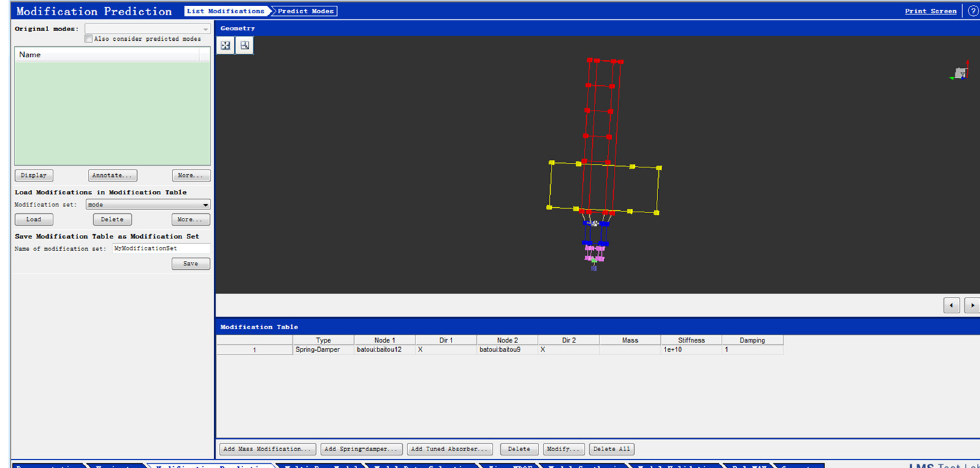
Figure 7. Parameter modification of modal prediction.